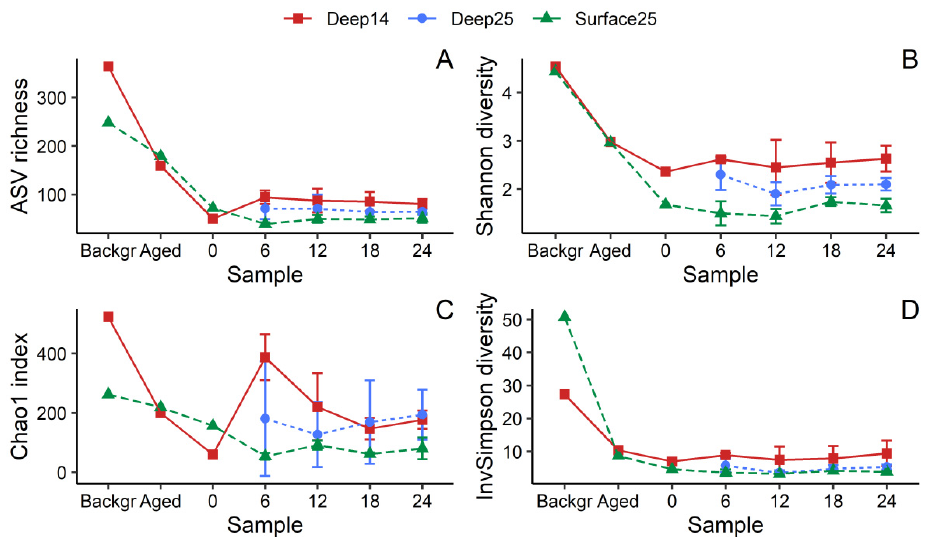
Figure 3. Measures of alpha diversity: ( A ) richness, ( B ) Shannon’s diversity index, ( C ) Chao1 index and ( D ) Inverse Simpson index. “Backgr” corresponds to the background microbial community in seawater at a 10 and 1040 m water depth. “Aged” is the seawater that was used as inoculum for the enrichment of consortia. Day 0 corresponds to consortia S2 and D2, which were selected for the microbial succession experiment.